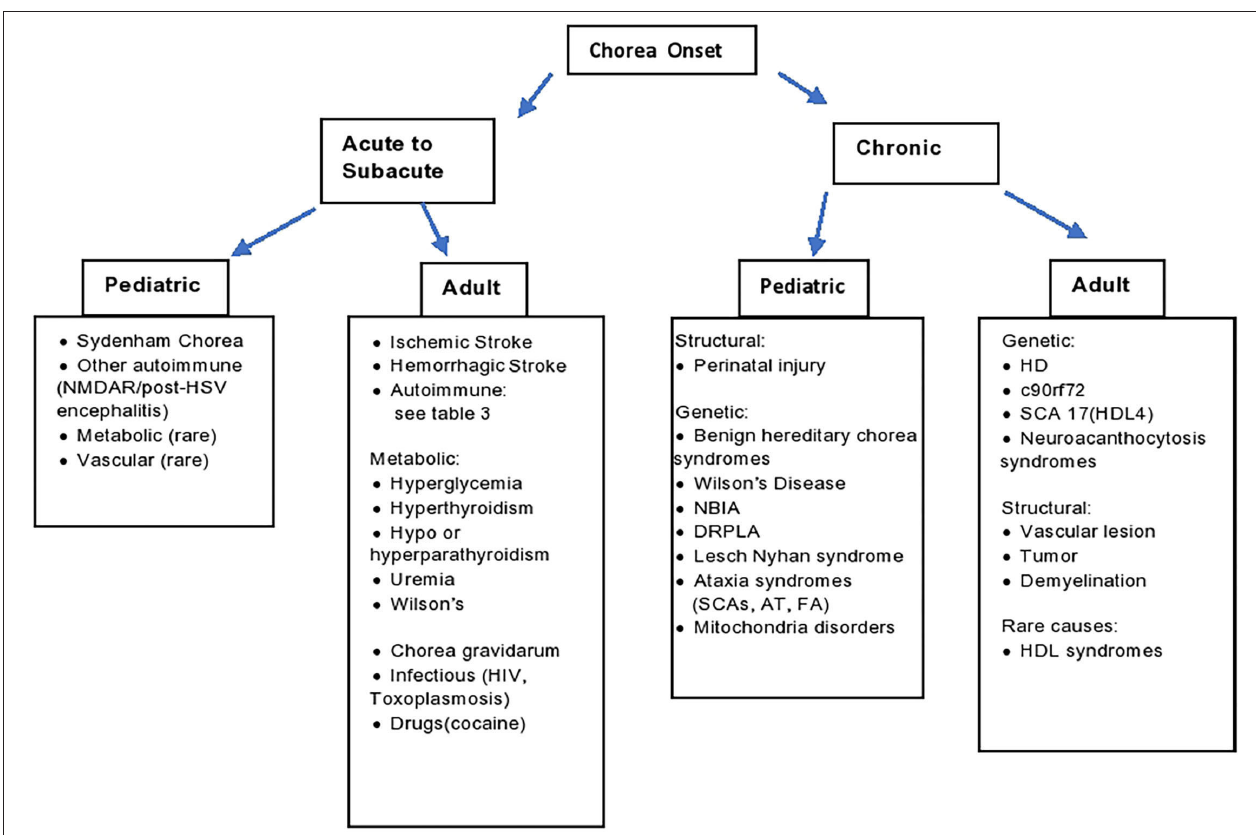
FIGURE 1 | Diagnostic algorithm. AT, ataxia telangiectasia; DRPLA, dentatorubral-pallidoluysian atrophy; FA, Friedrich’s ataxia; HD, Huntington’s disease; HDL, Huntington’s disease like; HIV, human immunodeficiency virus; HSV, herpes simplex encephalitis; NBIA, neurodegeneration with brain iron accumulation; SCA, spinocerebellar ataxia; SLE, systemic lupus